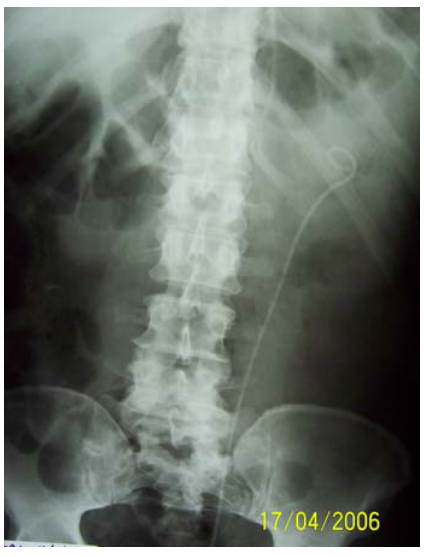
FIGURE 8. Double J catéter (7/17/06).